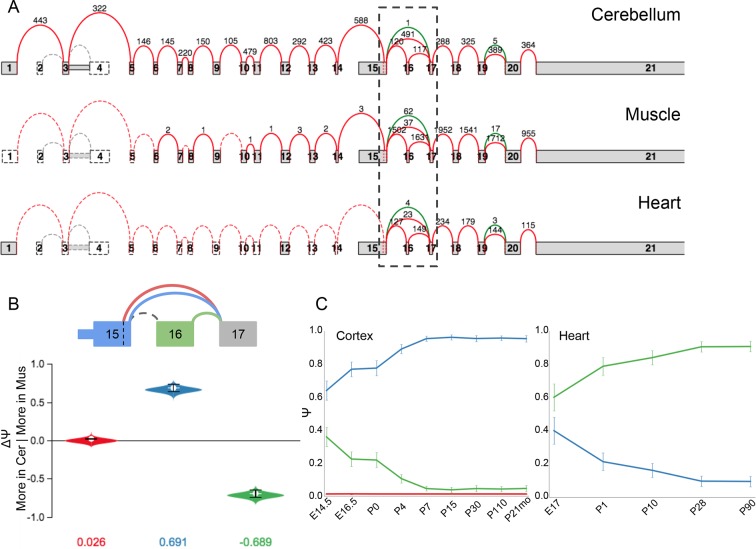
LSV in Camk2a is developmentally regulated oppositely in the brain
and heart.(A) Splice graph representation of Camk2a
across three tissues indicated. Dashed box indicates region containing
cassette exon that inserts a consensus NLS. (B) MAJIQ E[ΔΨ]
between cerebellum and muscle for inclusion (green) and exclusion (blue)
isoforms. Red junction corresponds to an alternative 5’ss not highly used
in any tissue. (C) Line graphs of MAJIQ Ψ quantification
(y-axis) of junctions as in (B) across time points (x-axis)
through cortex development (left) and heart development (right). Points
represent mean Ψ and error bars represent one standard deviation.